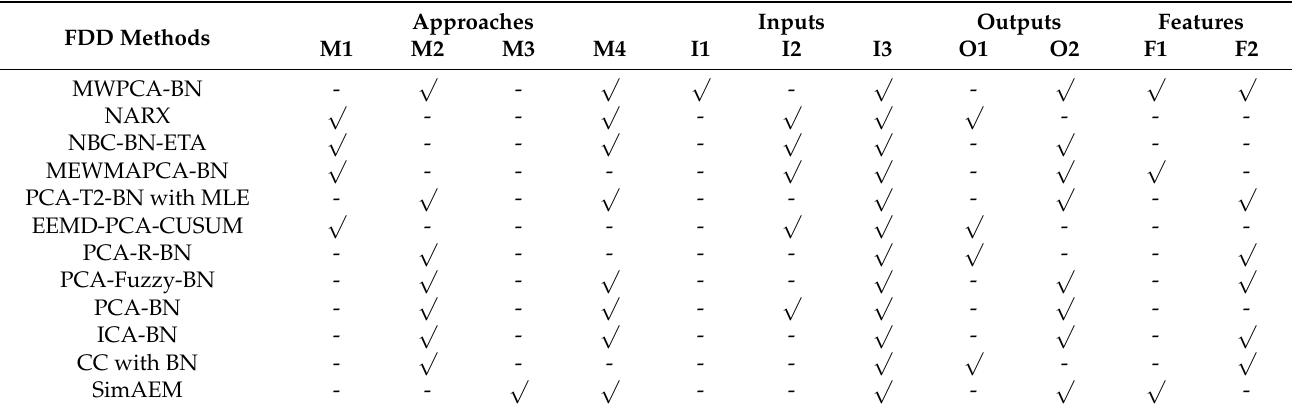
Table 1. FDD hybrid methods comparison results. FDD